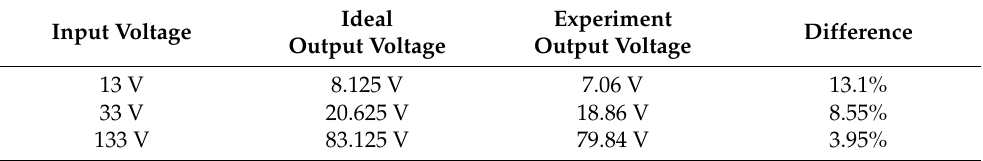
Table 5. Experiment